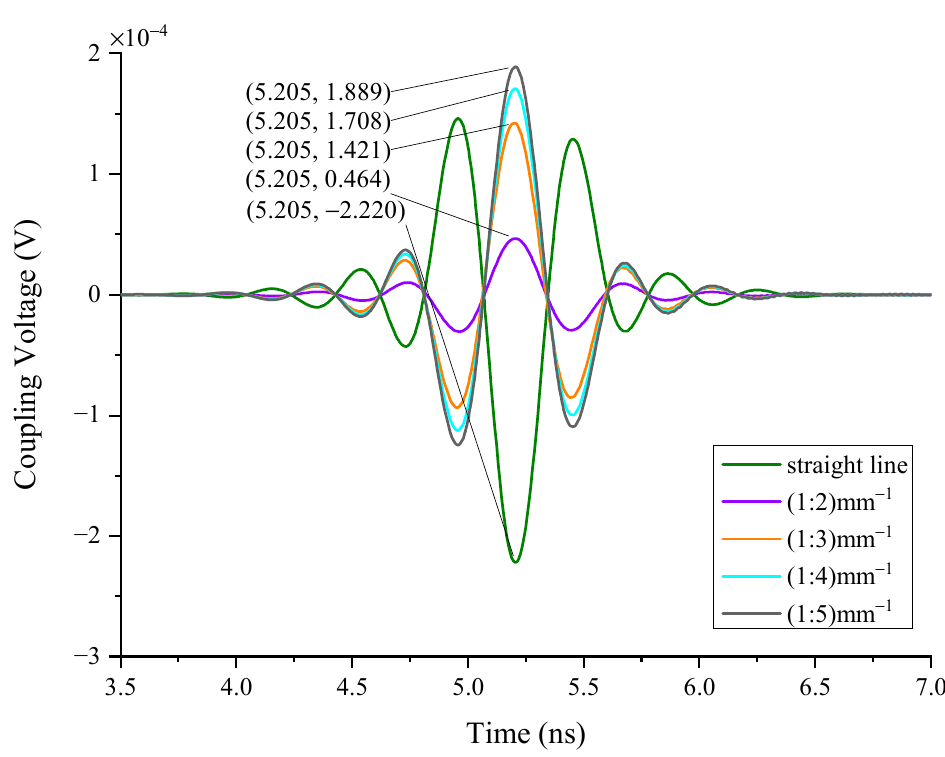
Figure 18. The responses of the different curvatures of a single wire.